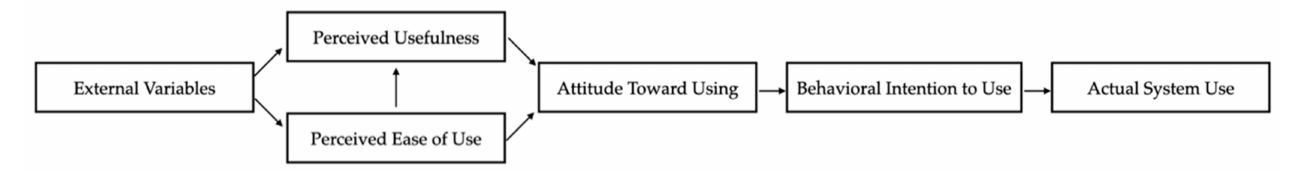
Figure 1. Technology acceptance model